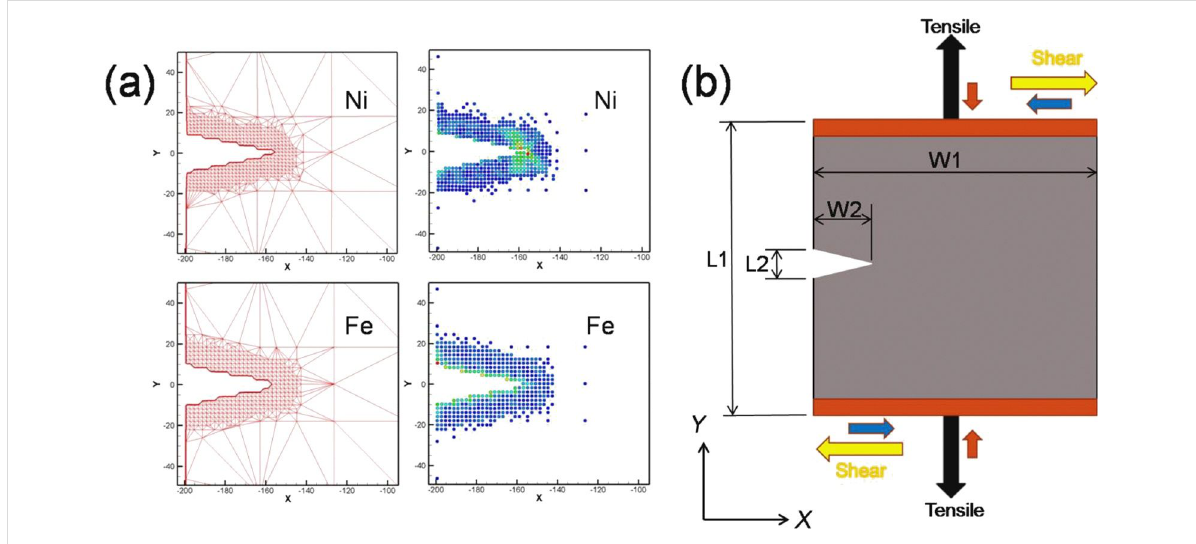
Figure 1: (a) Diagrams showing the physical models of Fe and Ni used in the simulations. (b) Diagram showing the sample under cyclic loading of tension–compression and shear–reverse shear, where W1 and L1 represent the width and length of the sample, which are 40 nm. W2 and L2 repre- sent the width and length of crack of the sample, which are 1.76 nm and 4.4 nm, respectively.